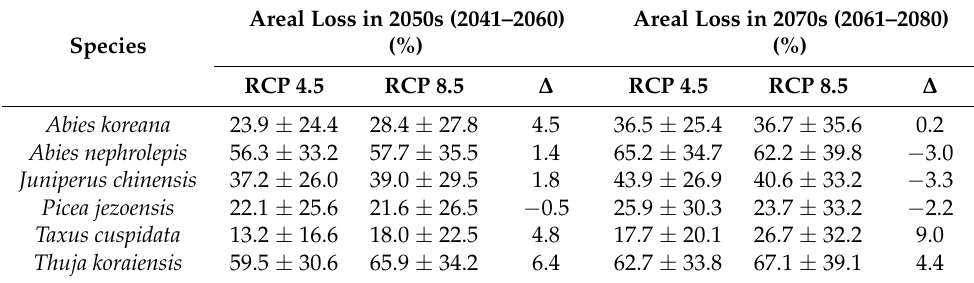
Figure 4. Land suitability maps of six subalpine forest species in South Korea for the 2070s (2061–2080) under RCP 4.5 ( upper ) and RCP 8.5 ( lower ) emission scenarios. Table 5. The projected loss of currently suitable habitat area, due to climate change for the 2050s and 2070s, based on RCP 4.5 and RCP 8.5 emission scenarios. ∆ is the areal loss difference between RCP 4.5 and RCP